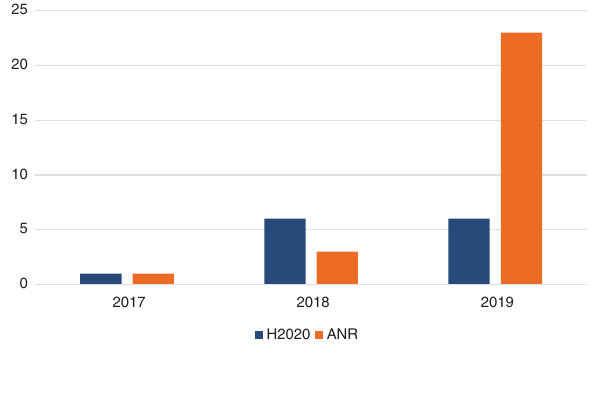
Fig. 2: Number of researchers supported for the writing of their grant proposal (1 st of December